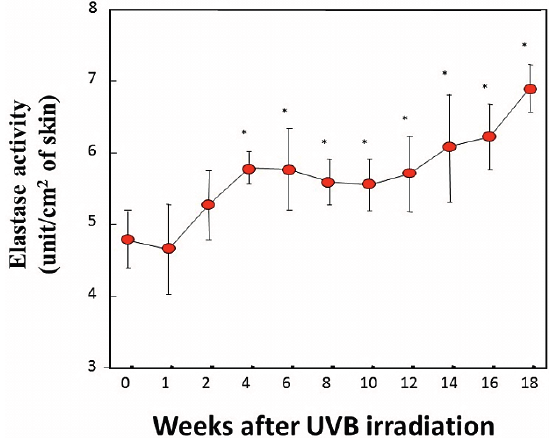
Figure 6. Elastase activity measured using N -succinyl- tri -alanyl- p -nitroaniline (STANA) as a substrate in UVB-exposed skin. Skin homogenates excluding subcutaneous tissue were used as the enzyme source for elastase activity. Mouse skin was biopsied 1 day after the indicated time of UVB irradiation, homogenized and processed for elastase